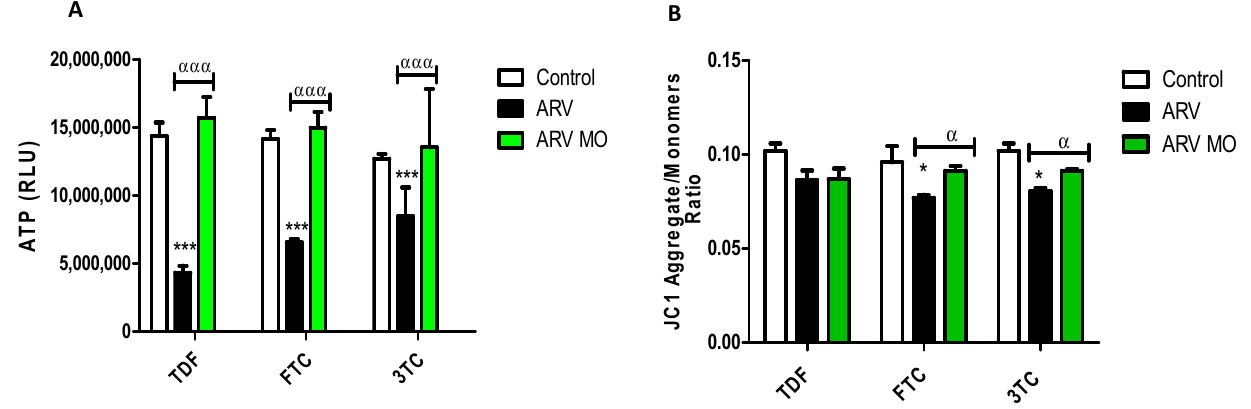
Figure 3. Assessment of mitochondrial integrity post-ARV and post-ARV MO treatment. ( A ) TDF, FTC, and 3TC significantly decreased the levels of intracellular ATP, whereas ARV MO displayed a significant increase in ATP in HepG2 cells. ( B ) ARVs significantly decreased the ∆Ψ m. In contrast, ARV MO significantly increased ∆Ψ m in HepG2 cells. * Represents a significant difference between the control and ARV (*, p < 0.05 and ***, p < 0.0001). α Represents a significant difference between ARV and ARV MO ( α , p < 0.05 and ααα , p < 0.0001).